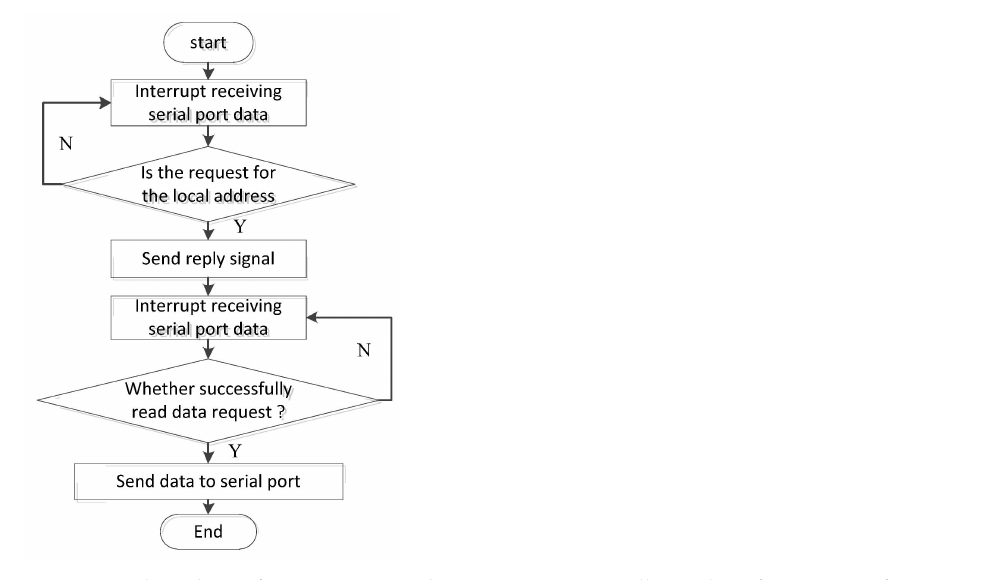
Figure 10. Flow chart of communication between microcontroller and configuration software.